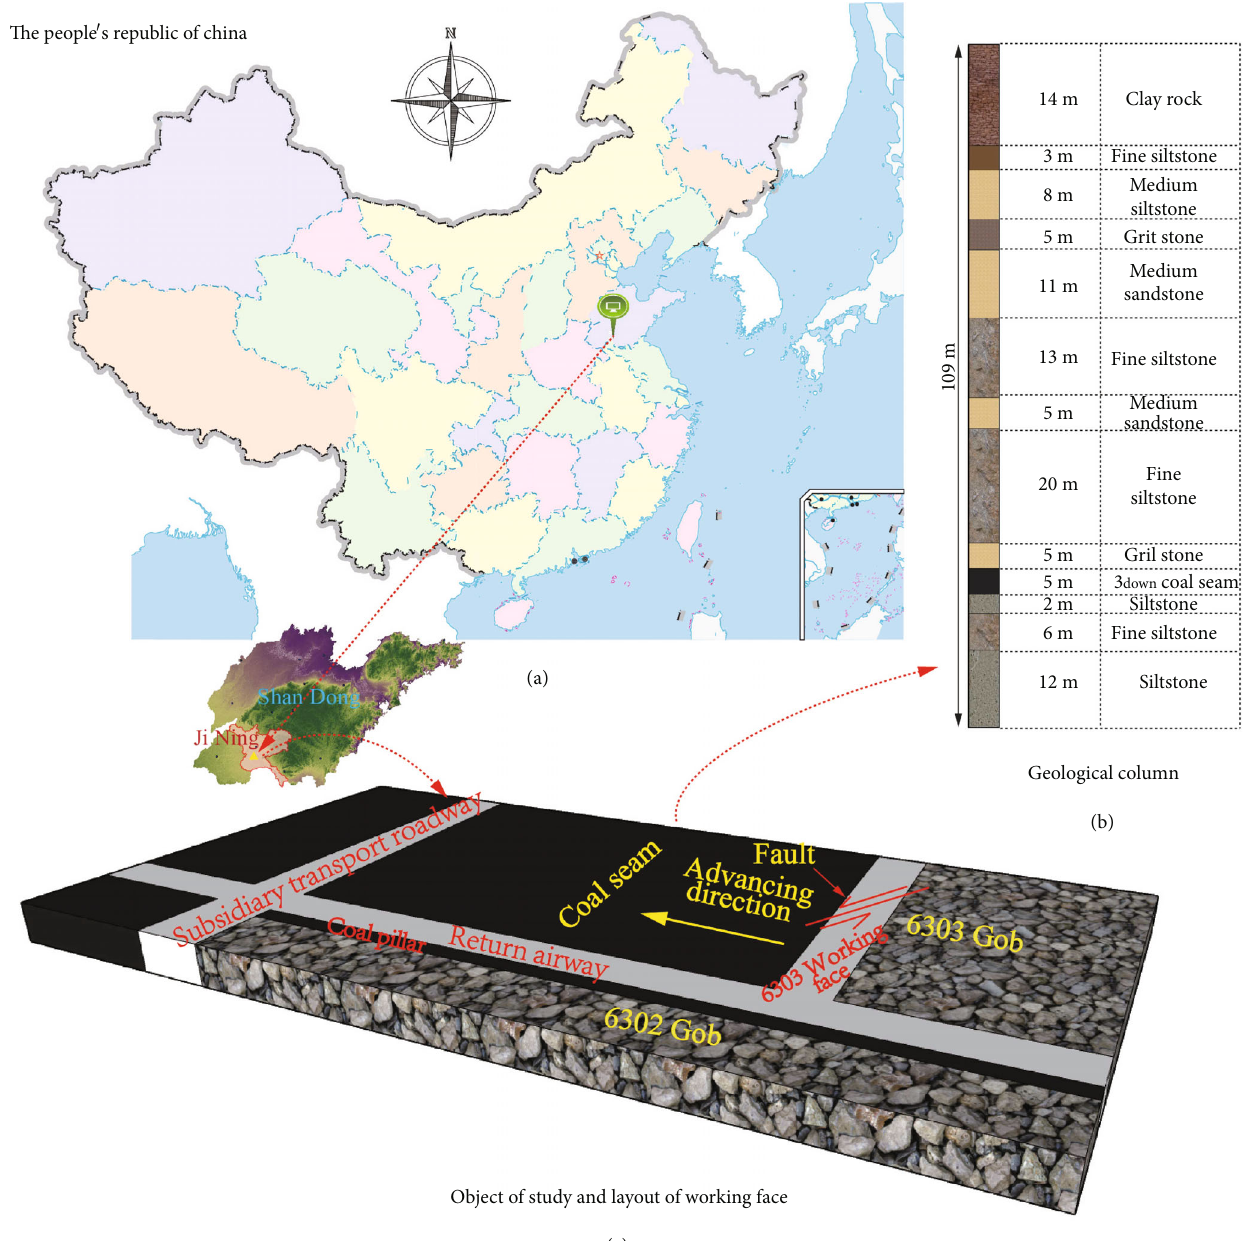
Figure 1: Location of the study area and layout of working